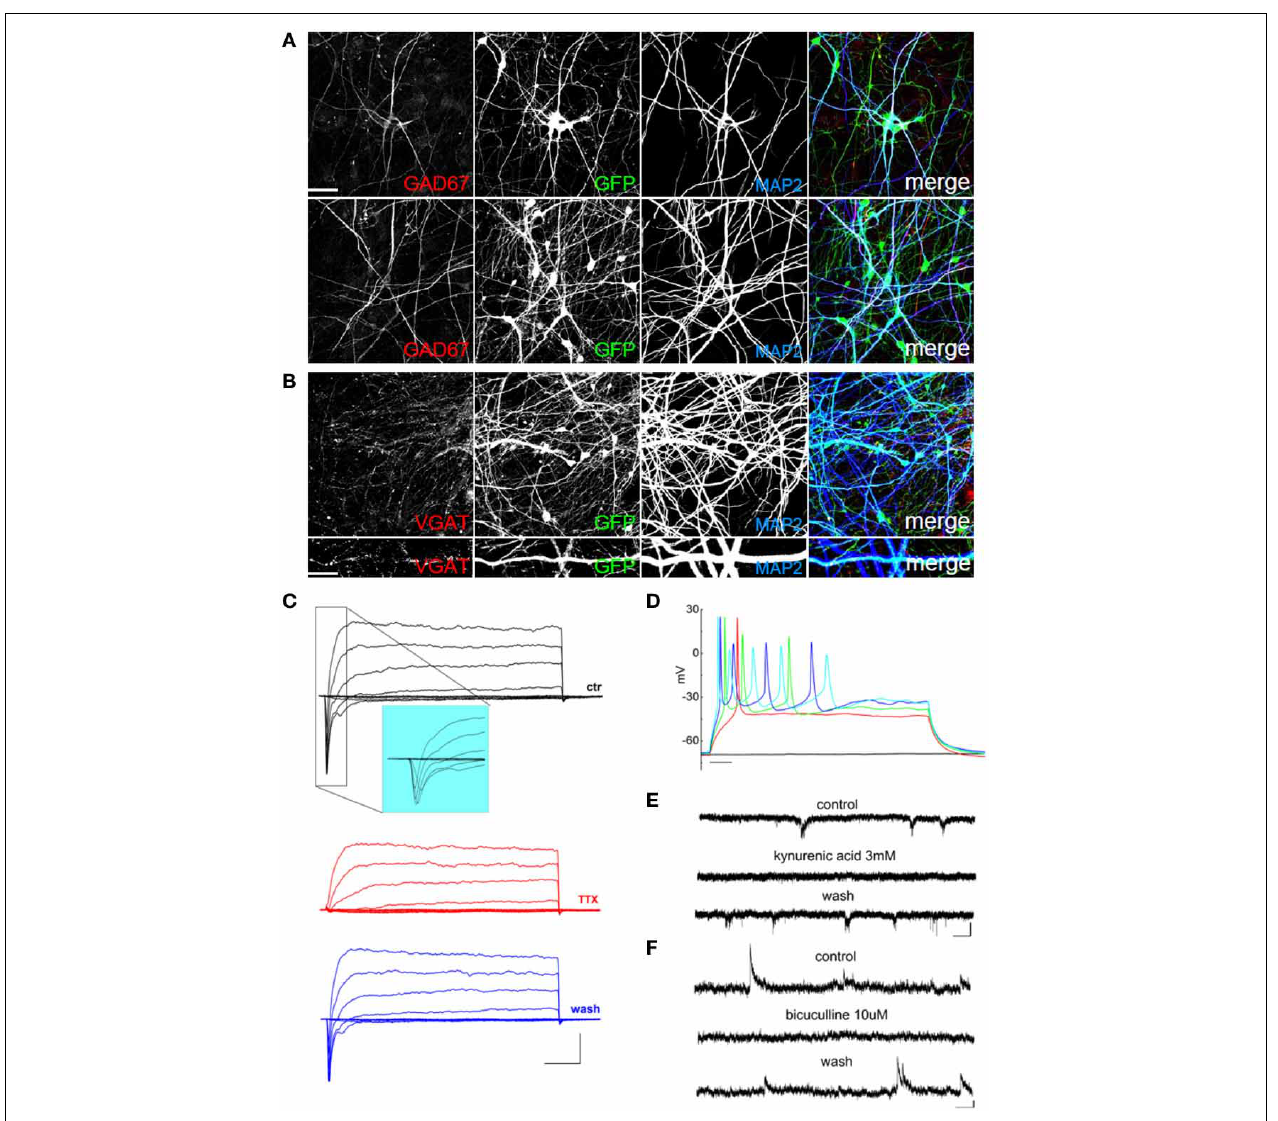
FIGURE 6 | Retinoic acid-induced differentiation of hNPs into GABAergic neurons. (A) hNP-derived neurons are positive for MAP2 and for the GABAergic marker GAD67 (red; left). Scale bar, 50 μ m. (B) hNP-derived neurons are positive for MAP2 and the GABAergic marker VGAT. Scale bar, 15 μ m. (C) representative total ionic current traces recorded with depolarizing voltage steps between − 70 and + 10mV (10mV increments from a holding potential of − 70mV) from hNP-derived neurons. From top to bottom: currents in control (black), with perfusion of tetrodotoxin 1 μ M (red) and after washout (blue). Scale bars, 10ms, 500pA. The inset shows an enlargement of the traces in control, for better displaying voltage gated sodium currents. (D) Representative firing traces recorded from hNP-derived neurons during application of